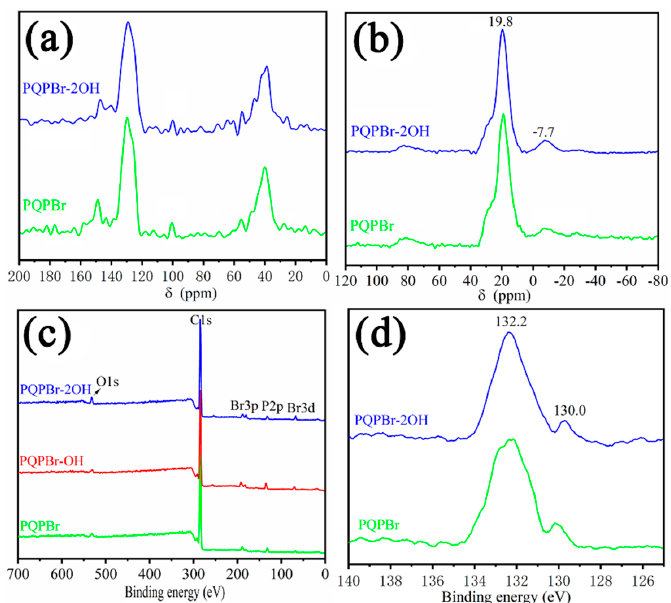
Figure 4. ( a ) Solid ‐ state 13 C nuclear magnetic resonance (NMR) spectra of PQPBr and PQPBr ‐ 2OH; ( b ) solid ‐ state 31 P NMR spectra of PQPBr and PQPBr ‐ 2OH; ( c ) XPS full spectra of PQPBr, PQPBr ‐ OH and PQPBr ‐ 2OH; ( d ) P 2p XPS spectra of PQPBr and PQPBr ‐ 2OH.